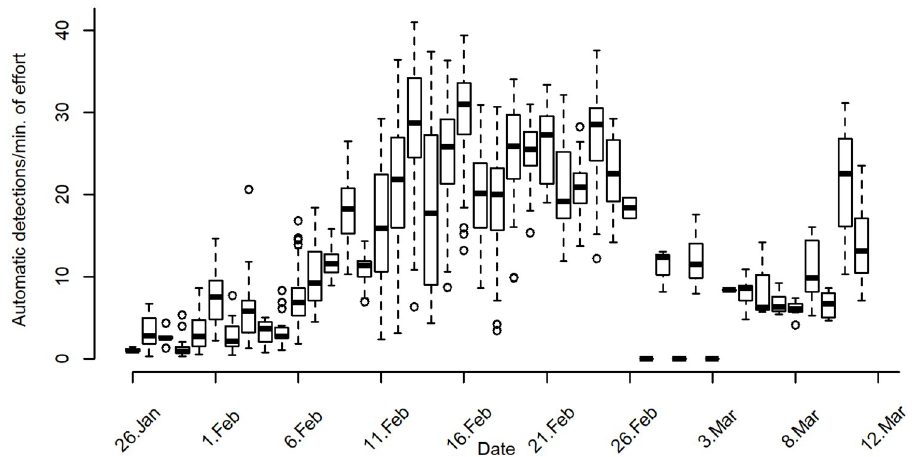
Fig 3. Song detections. Humpback whale song detection distribution per day of recording, i.e. during January 26 th to March 12 th 2011.